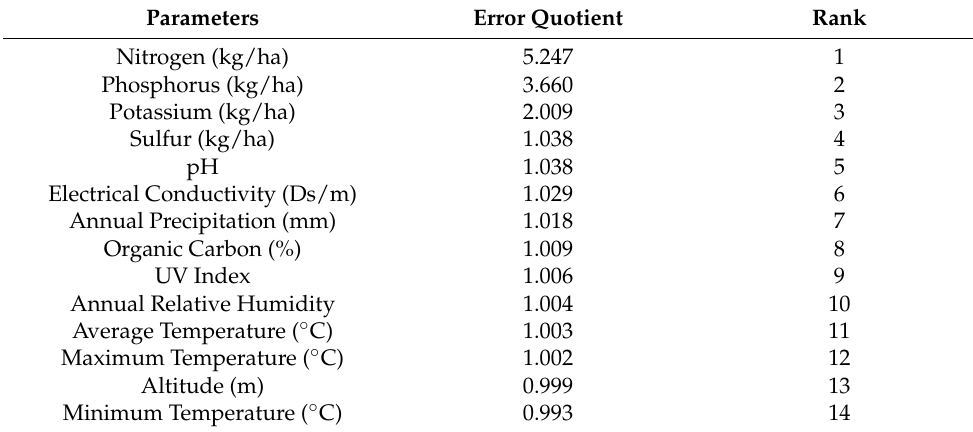
Table 1. Sensitivity analysis of the neural